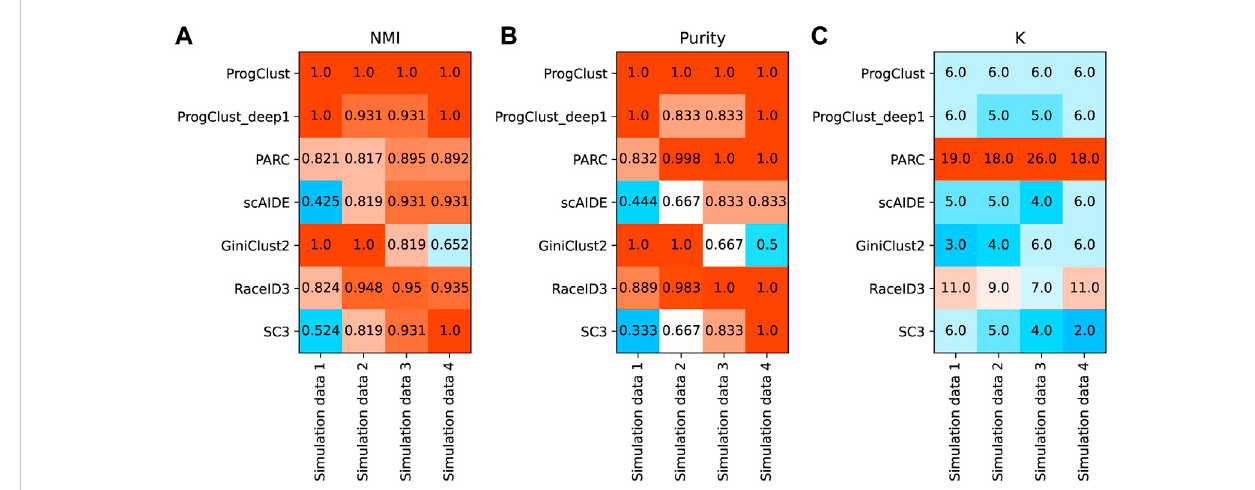
FIGURE 4 The clustering results of each clustering method on simulation data 3 (other data are provided in the Supplementary Material S1). X -axis represents the cluster index, and y -axis represents the number of cells. Different colors in the same cluster represent the proportion of different types of cells.